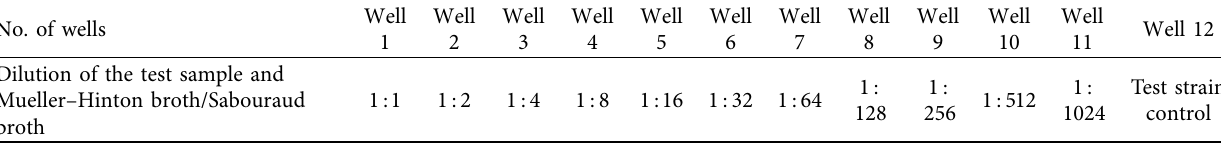
Table 1: Labelling of Petri dishes according to